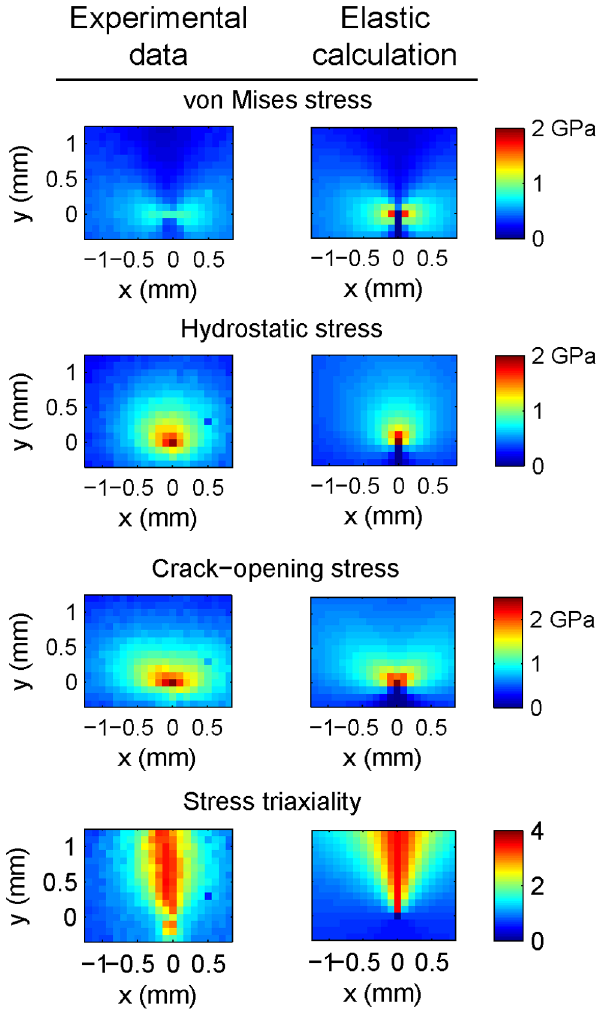
Figure 4. Comparison of crack-tip stress fields from experi- mental data (left-hand side of each pair) with a fully elastic, plane-strain calculation for amorphous Zr 57 Ti 5 Cu 20 Ni 8 Al 10 loaded to K I ~ 47 MPam 1 = 2 at room temperature.